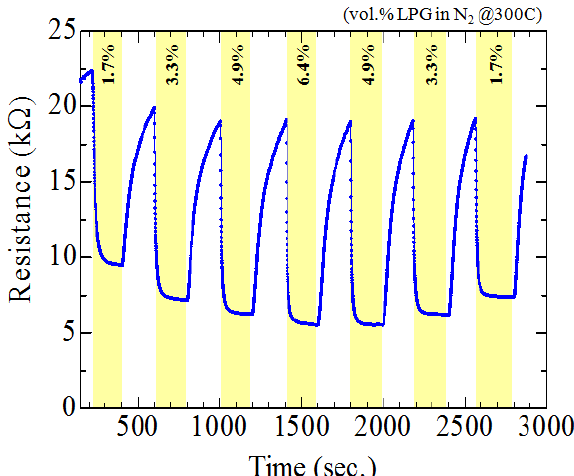
and LPG (1.7~6.4 vol.%). 2